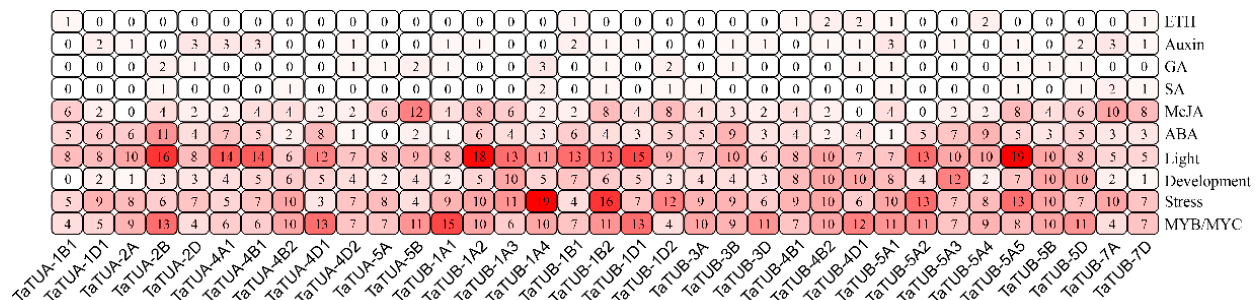
Figure 5. Analysis of the cis-element in TaTUA and TaTUB gene promoters.